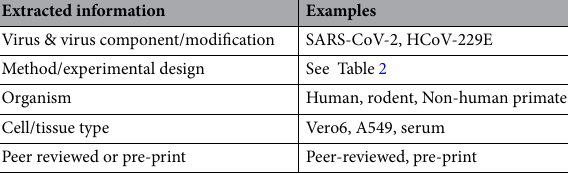
Table 3. Data extracted from each